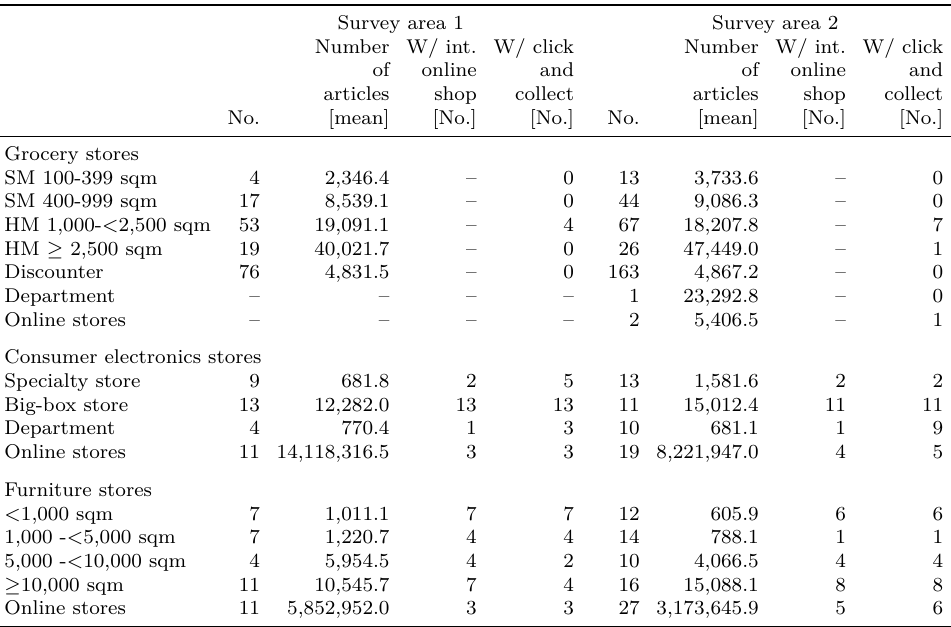
Table 4: Included stores by survey area, retail sector and store format Survey area 1 Survey area 2 Number W/ int. W/ click Number W/ int. W/ click of